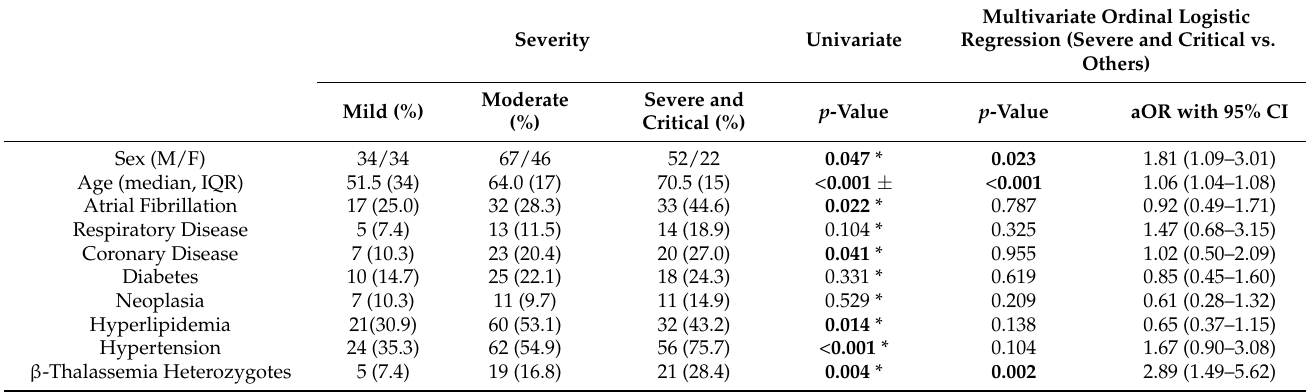
Table 1. Characteristics and COVID-19 clinical spectrum.